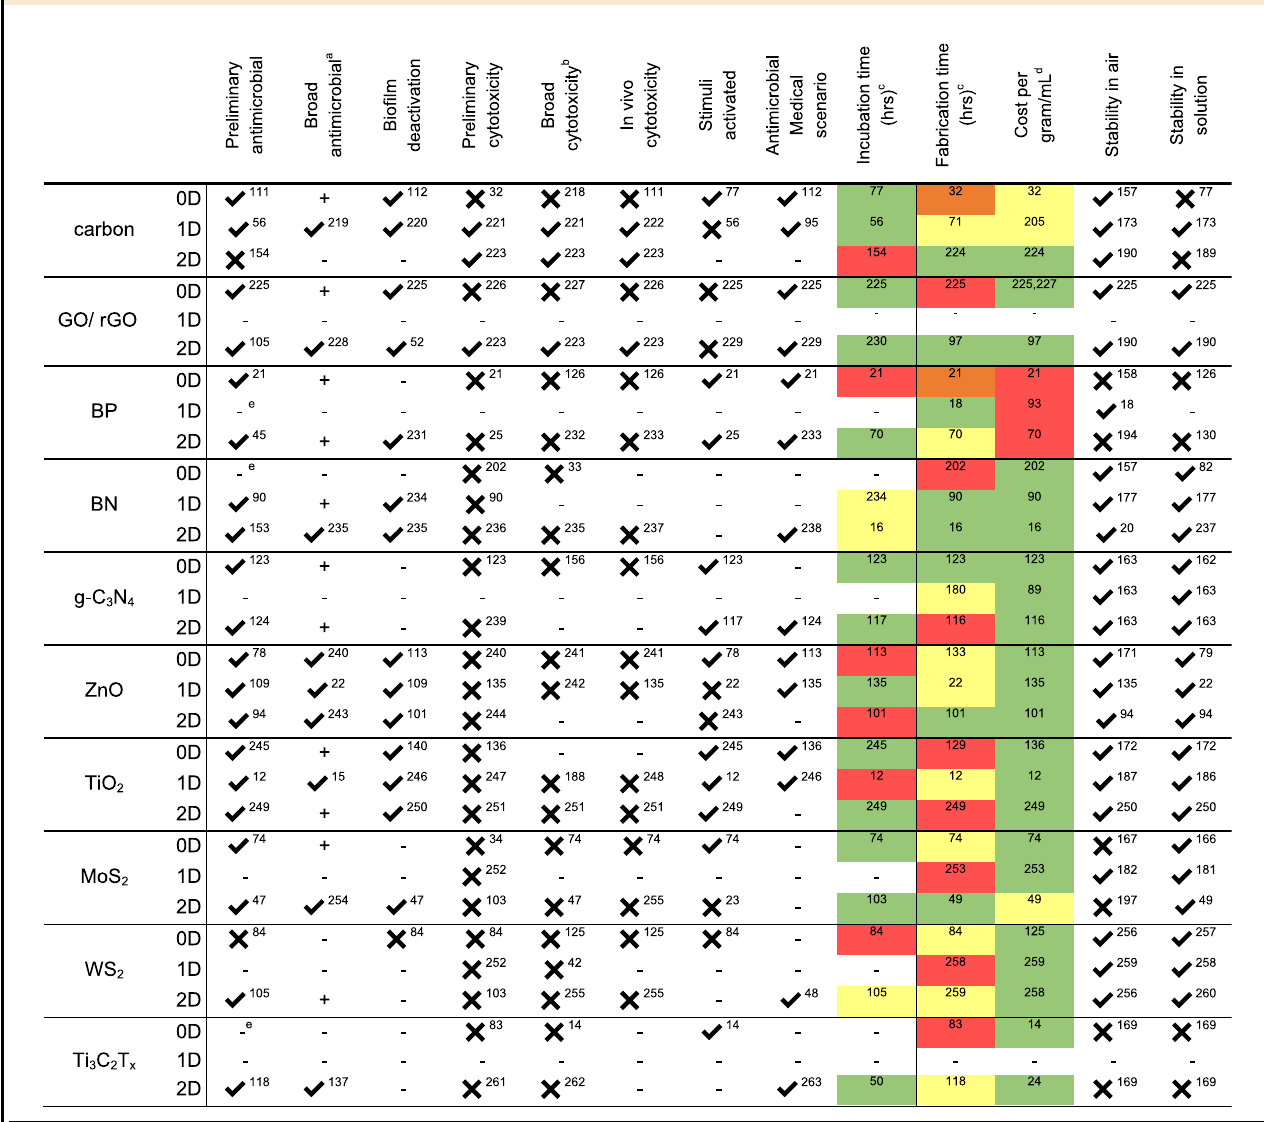
Table 2 Summary of LDMs for antimicrobial applications 218 – 263